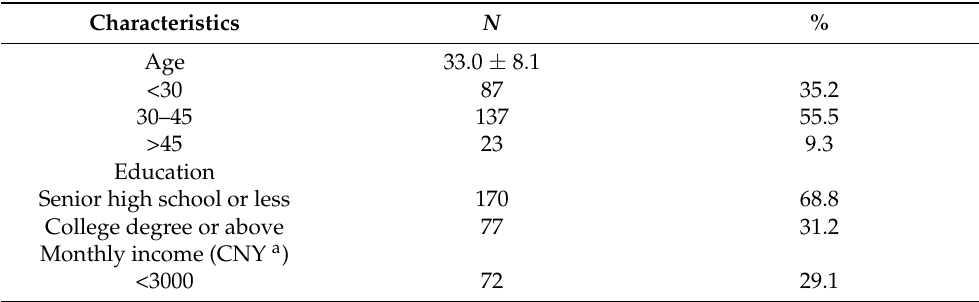
Table 1. Sociodemographic characteristics of transgender women ( N =